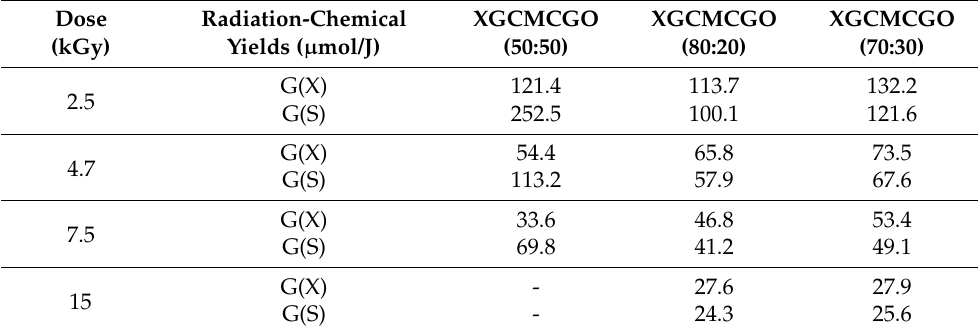
Table 2. Radiation-chemical yield of crosslinking G(X) and chain scission G(S) calculated for the XGCMCGO